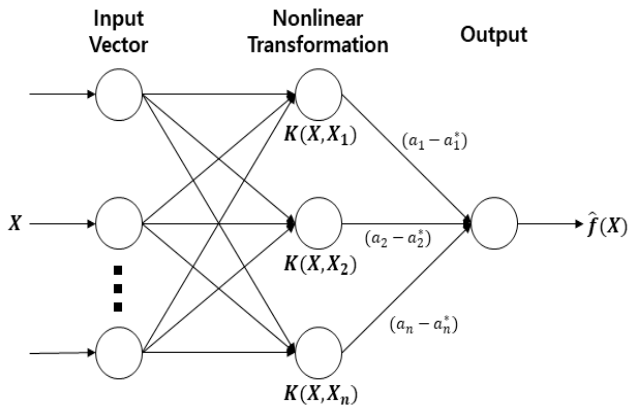
Figure 6. Structure of support vector regression with nonlinear function. Figure 6 Structure of support vector regression with nonlinear function.